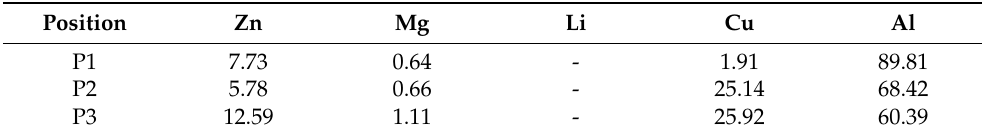
Figure 2. The as-cast microstructure of the 13Zn alloy viewed with ( a ) Low-magnification SEM; ( b ) High-magnification SEM; ( c ) IQ (Image Quality) image of EBSD; ( d ) Phase distribution image of EBSD. Table 2. EDS composition analysis results of P1 to P3 in Figure 2b (at.